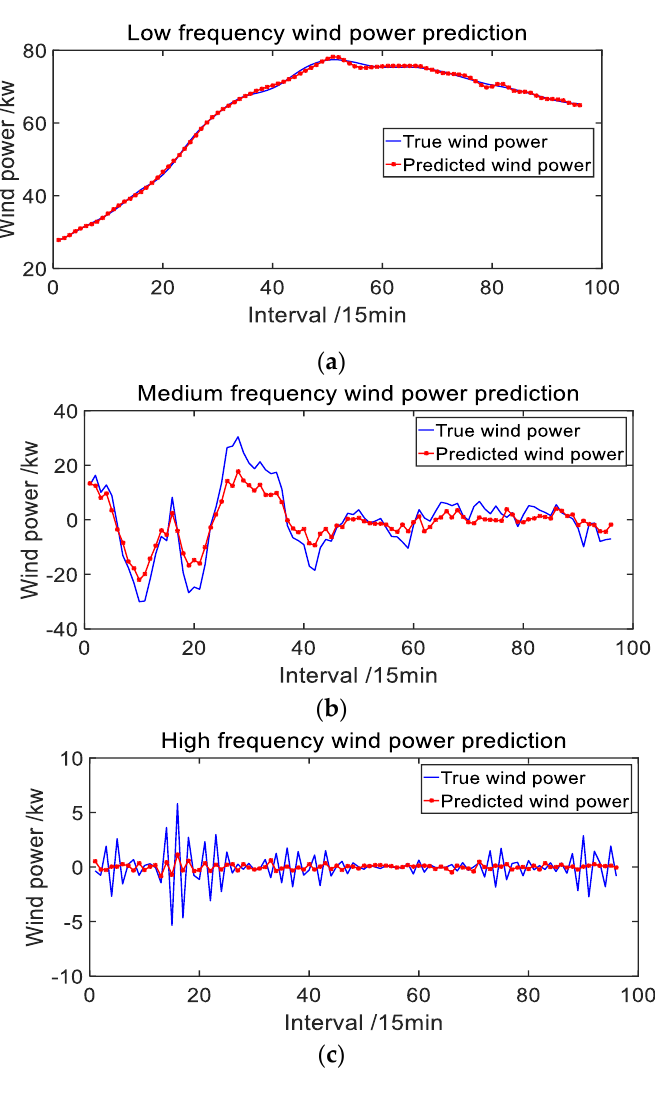
Figure 8. Three frequency waveform prediction sketch diagrams. ( a ) Low-frequency wind power prediction, ( b ) medium-frequency wind power prediction, and ( c ) high-frequency wind power prediction.